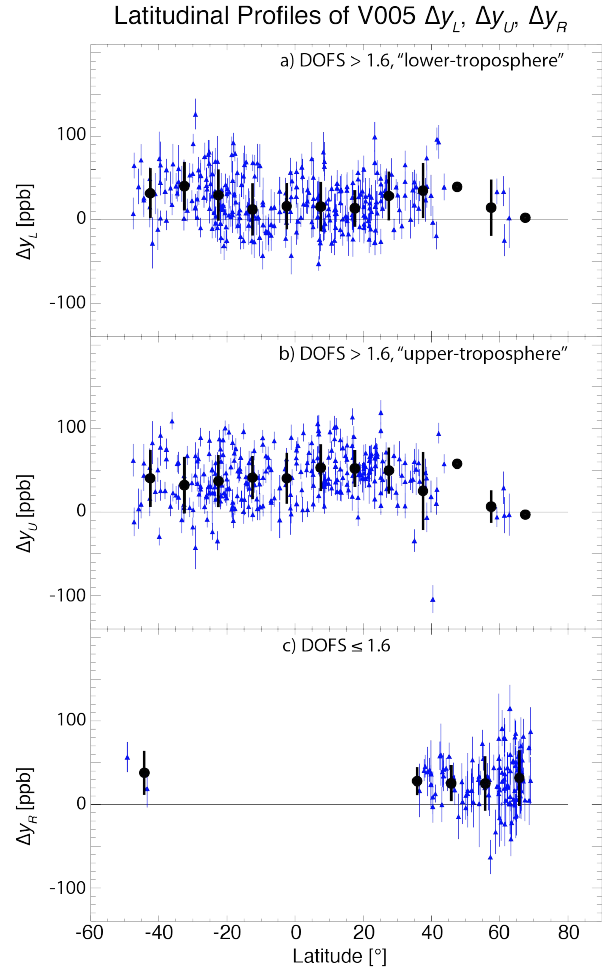
Fig. 6. Latitudinal profiles of the differences 1y between TES V005 and HIPPO methane concentrations during HIPPO I and II in January and October–November 2009. The top two panels show results for the lower and upper tropospheric TES data ( 1y L and 1y U , respectively) in scenes where the degrees of freedom for sig- nal (DOFS) exceeds 1.6. The bottom panel shows results for the RTVMR ( 1y R ) in scenes where the DOFS is lower than 1.6. Blue vertical bars are the theoretical error standard deviations reported in the TES retrievals. Black circles and vertical bars are the means and standard deviations binned by 10 ◦ latitude.